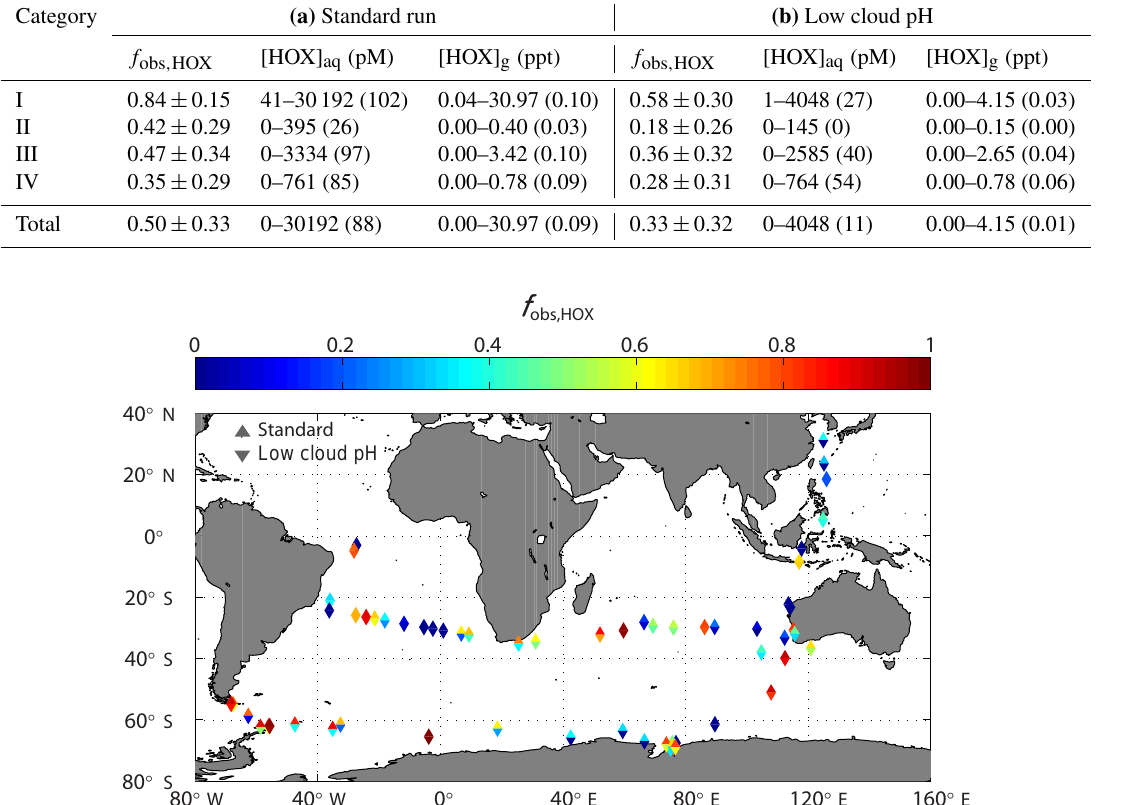
Figure 4. Calculated f obs , HOX for each sample using modeling results from the standard run (upward-pointing triangle) and low cloud pH run (downward-pointing triangle),